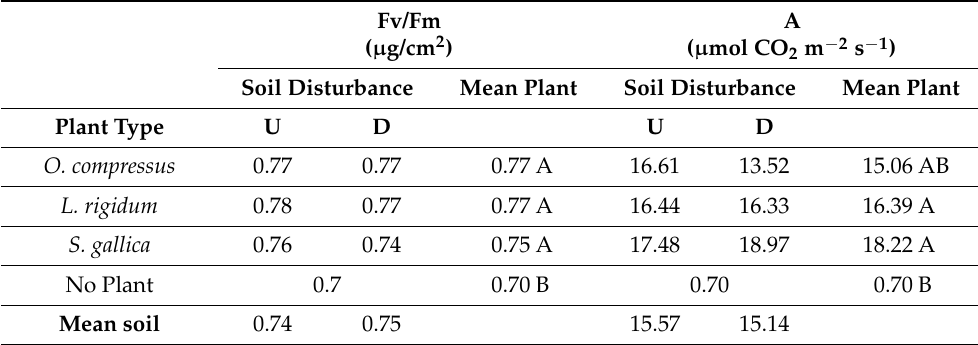
Values sharing different letters indicate significant differences between treatments at the 5% level (Tukey’s t -test). U: undisturbed treatment and D: disturbed